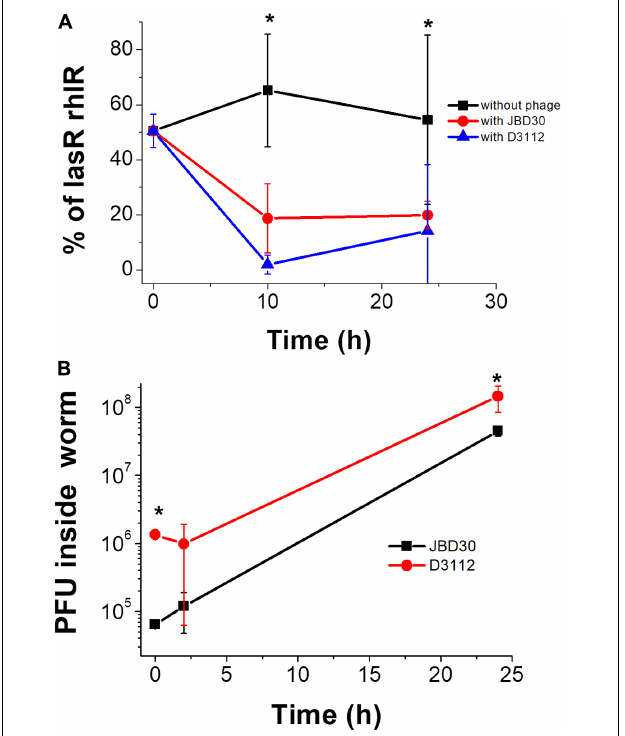
FIGURE 4 | (A) In vivo selection of the QS phenotype by the addition of D3112 or JBD30 phage during a Galleria mellonella infection with the wild-type and lasR rlhR mutant presented as a 50% initial mixture. Experiments were done in four independent cultures, and the average is shown. (B) Phage replicates inside the infected worms. Experiments were done counting the pfu in three independent worms per phage (averages are shown). The differences between the proportion of the mutant without and with either phage at 10 and 24 h are significant except for D3112 at 24 h, P < 0.05, in a two-tailed t -test ( ∗ ), as well as the increase of either phage at 24 h, P < 0.05, in a two-tailed Student’s t